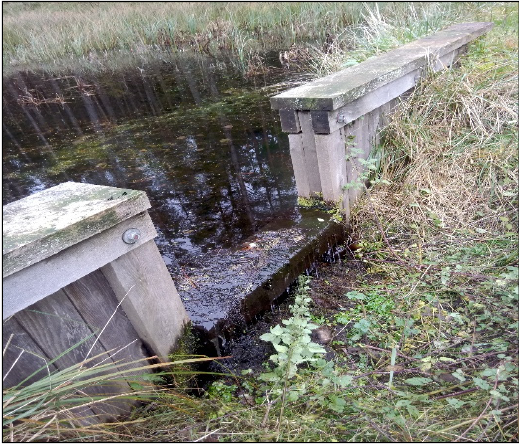
Figure 3. A damming step, the Karnieszewice Forest District (Photo: A. Krysztofiak ‐ Kaniewska).